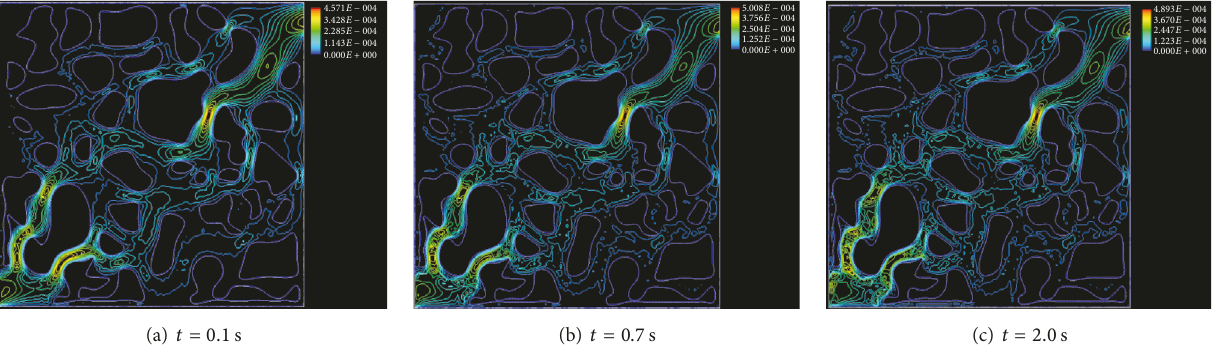
Figure 9: Velocity contours with different relaxation time through complex micromodel ( 𝜆 = 0.15 s).